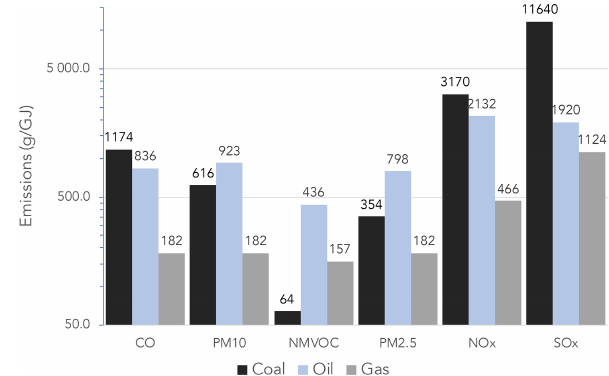
Figure 4. Emission factors (gGJ − 1 ) for different types of